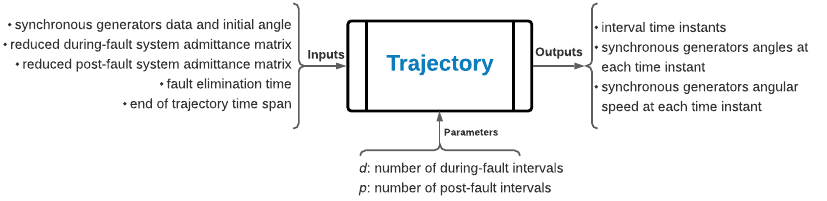
Figure 15. Schematic representation of Trajectory function to find synchronous generators’ angle trajectory in